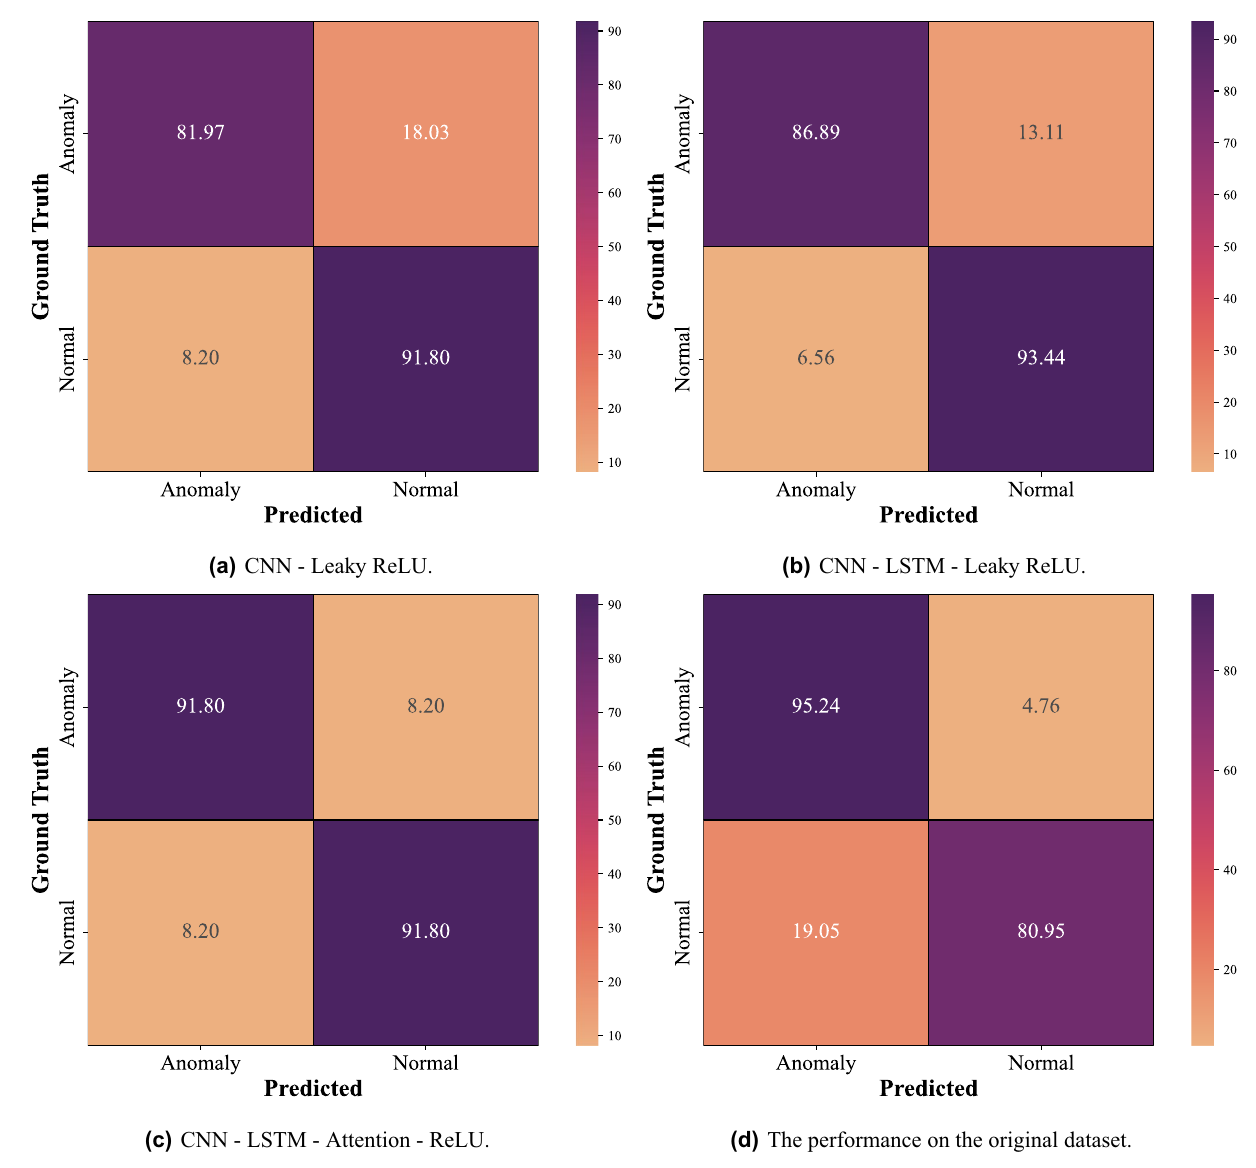
Figure 6. Comparison of different methods.